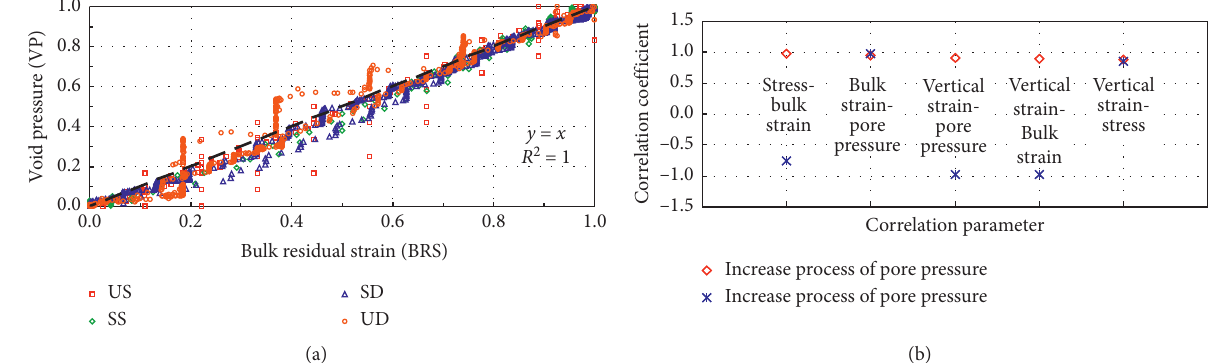
Figure 6: The same responding process of void air/water pressures under bulk residual strain and their controlling relation analysis. (a) Identical response process (samples 1–10). (b) Controlling relation analysis (sample